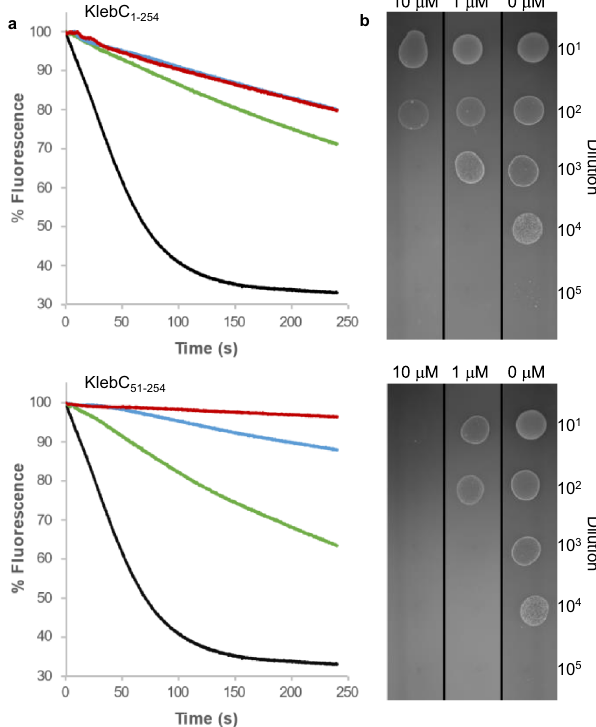
Fig. 4 KlebC fragment-based inhibition of TolC ef fl ux activity resulting in decreased viability of K. quasipneumoniae . a Inhibition of Nile Red Ef fl ux through TolC in the presence of 100 µ M (red), 10 µ M (blue), 1 µ M (green) or 0 µ M (black) KlebC 1-254 or KlebC 51-254 . Data shown are one representative experiment of two biological repeats. b Growth of serial dilution of K. quasipneumoniae prepared in the presence of 10, 1 or 0 µ M KlebC 1-254 or KlebC 51-254 when plated onto LB-Agar in the presence of 1 mg ml − 1 Rhodamine 6G.